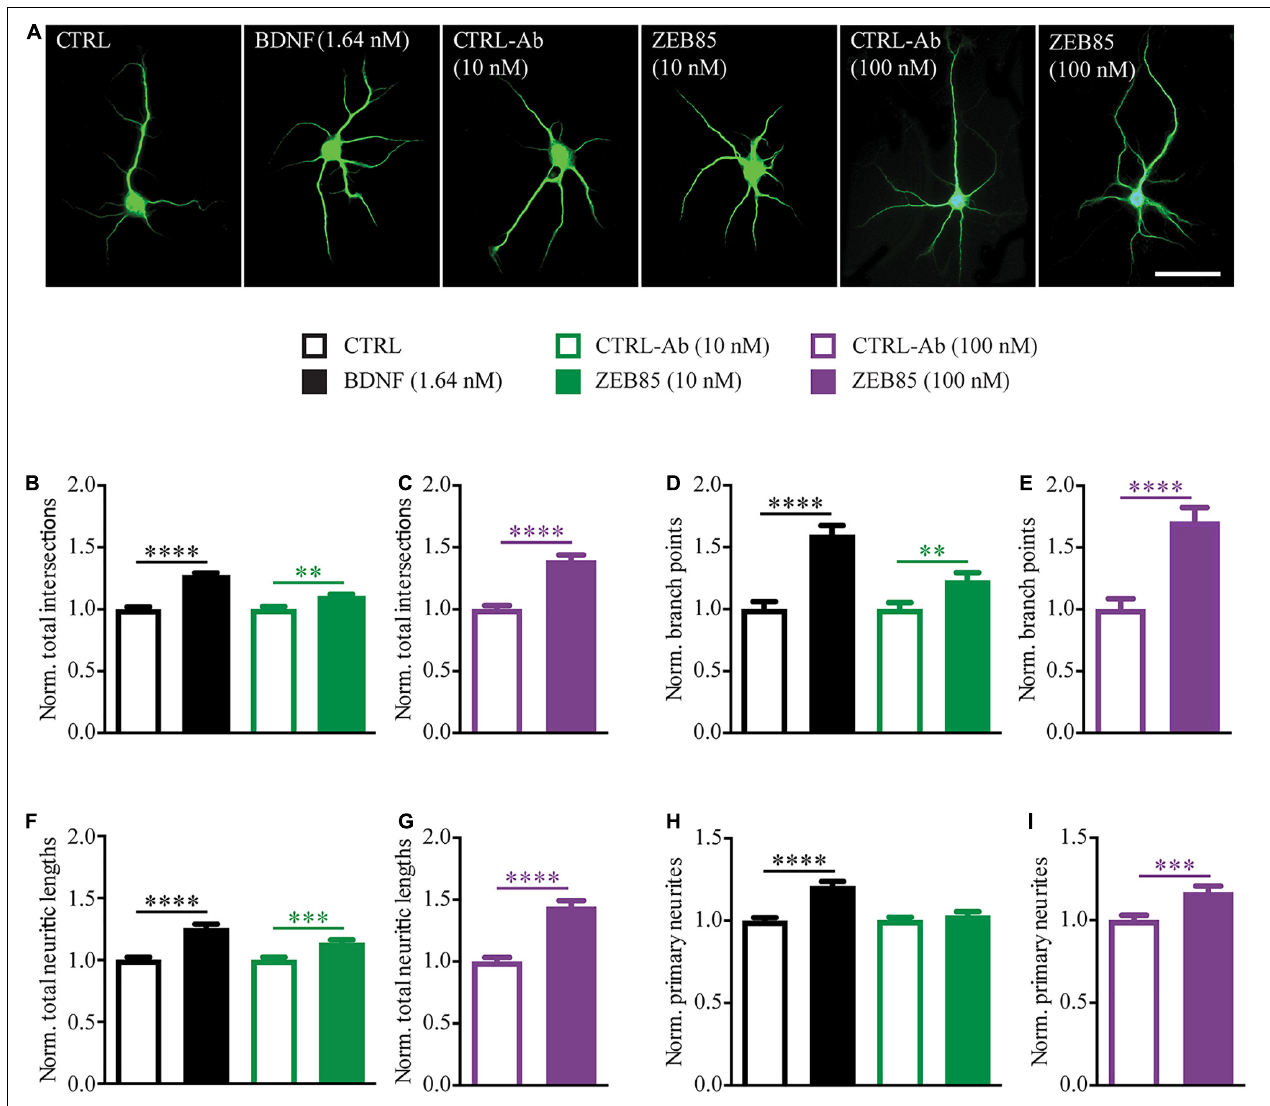
FIGURE 1 | ZEB85 increases neurite complexity of developing hippocampal neurons. Primary hippocampal neurons DIV3 were treated for 4 days with ZEB85 (10 nM and 100 nM), control-antibody (CTRL-Ab) or with BDNF (1.64 nM) and its respective control (CTRL). (A) Representative images for the different treatment groups immunostained for MAP2 at DIV7. Scale bar, 50 µ m. (B–I) Sholl analysis was performed to analyze neurite complexity and data was normalized to the respective controls: (B,C) total number of intersections, (D,E) number of branch points, (F,G) total neurite length and (H,I) number of primary neurites. (CTRL, CTRL-Ab 10 nM and ZEB85 10 nM: n = 141 neurons; BDNF: n = 140; CTRL-Ab 100 nM: n = 91; ZEB85 100 nM: n = 94; N = 3 independent experiments). The data are presented as mean ± SEM and were tested using an unpaired t -test. ∗∗ p < 0.01; ∗∗∗ p < 0.001; ∗∗∗∗ p < 0.0001.